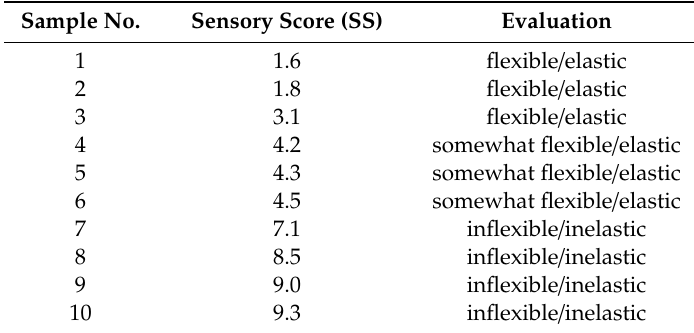
Table 1. Results of the sensory